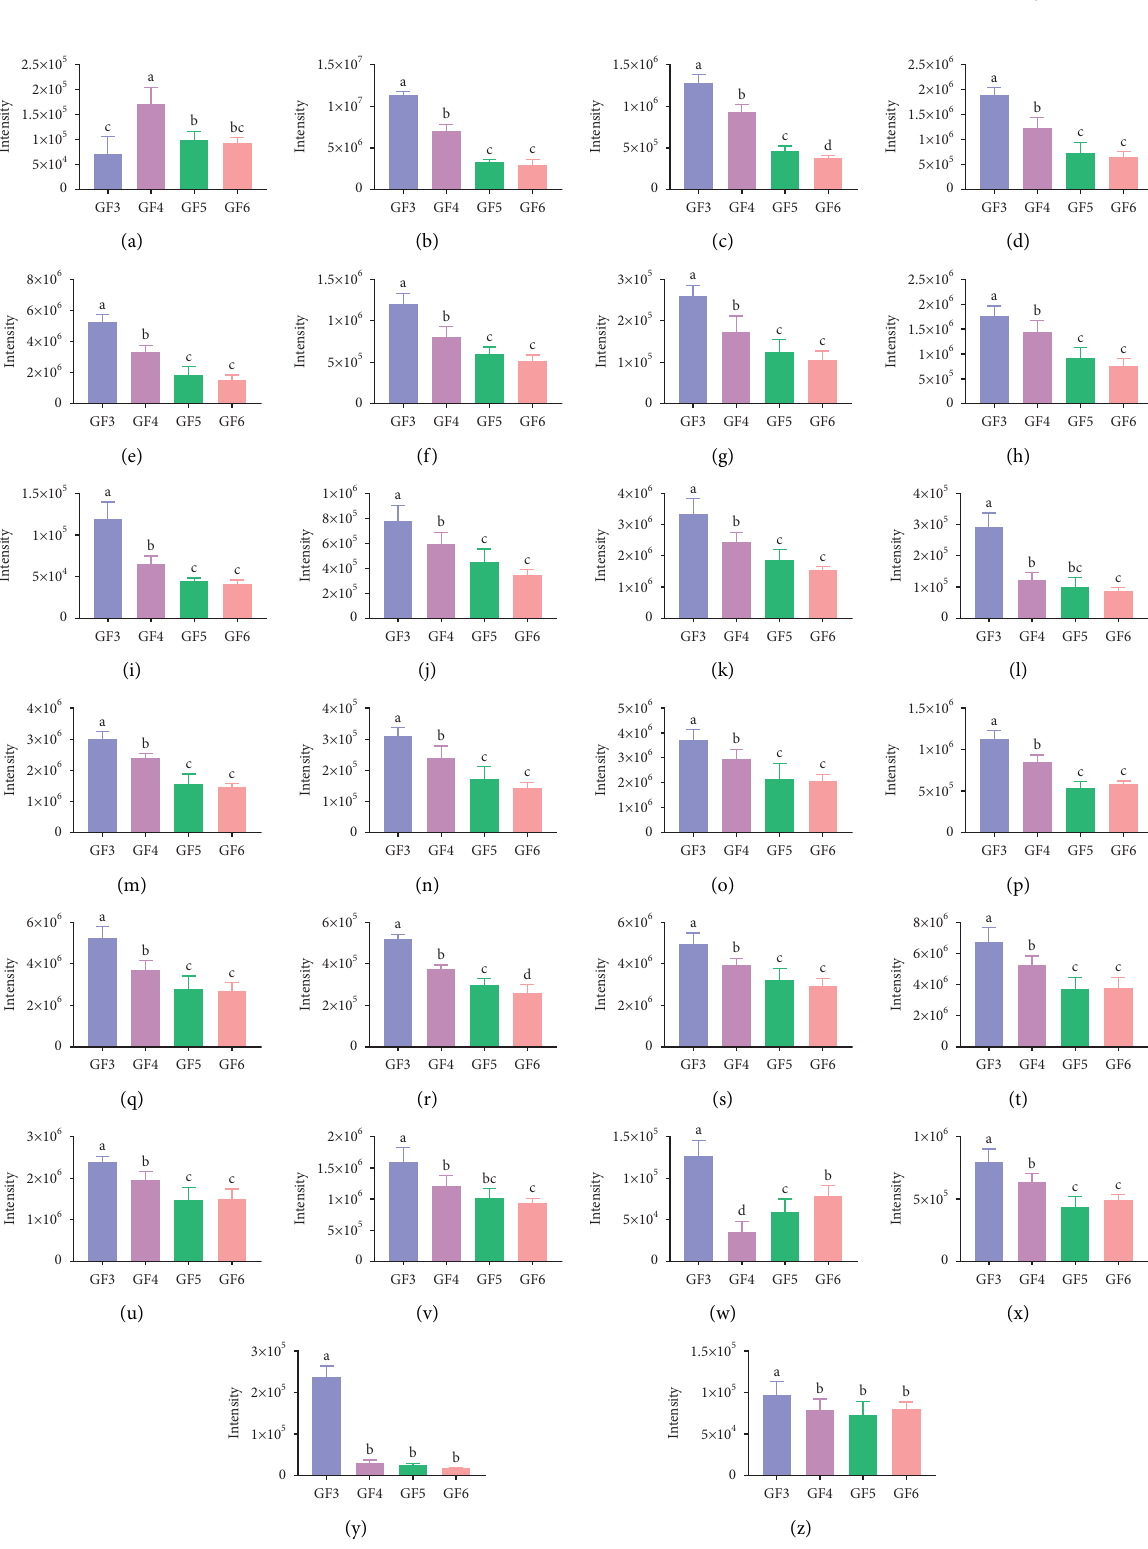
Figure 5: Profles of 26 common diferential metabolites from ginseng fower-revealing changes in intensities within various ages. Under Duncan’s new multiple range test, diferent lowercase letters in the histogram by signifcant diferences ( p < 0 . 05 ) were